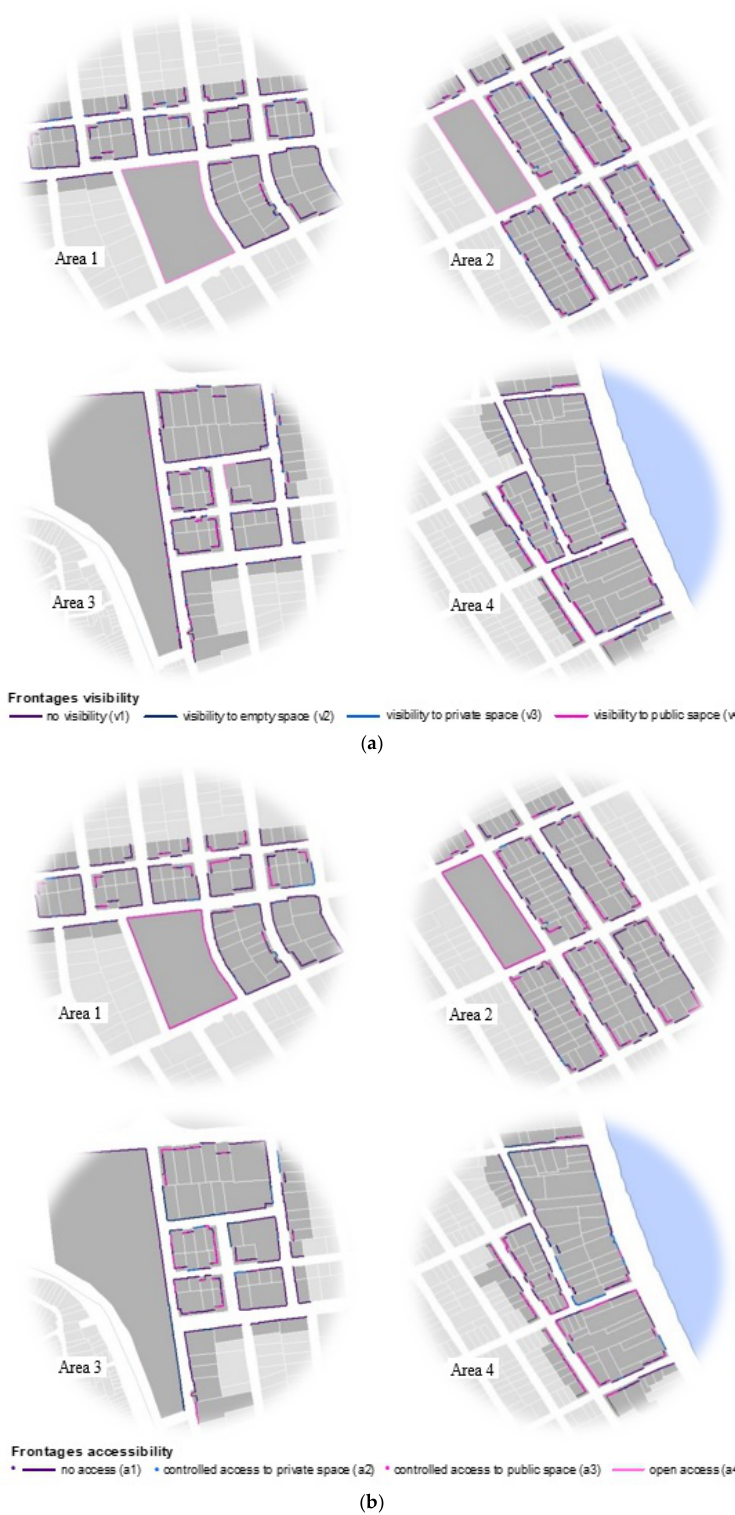
Figure 2. ( a ) Maps of the four testing areas, showing frontages visibility; ( b ) maps of the four testing areas, showing frontages accessibility.